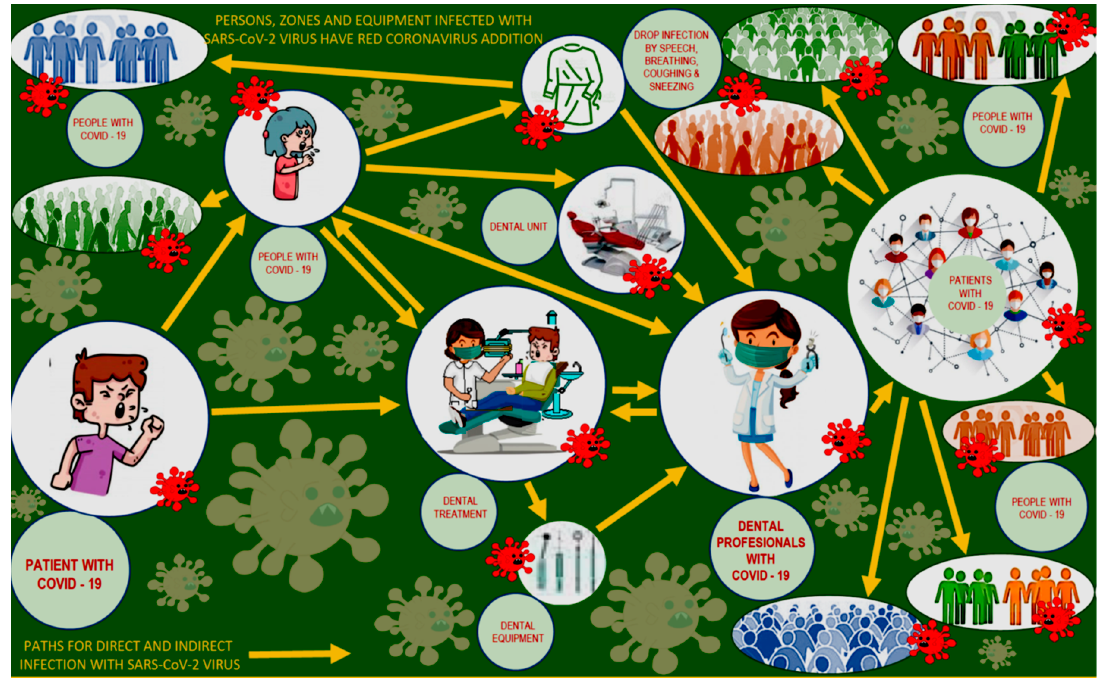
Figure 35. Diagram of SARS-CoV-2 transmission via a dentist in the event of one infected patient appearing in a dental clinic.